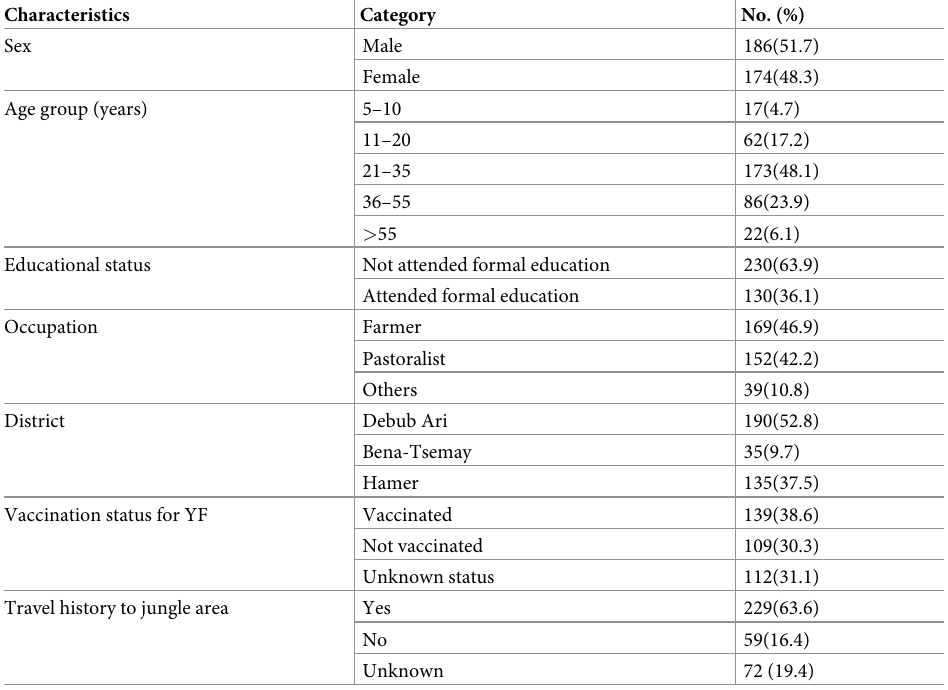
Table 1. Background characteristics of the study participants (N =